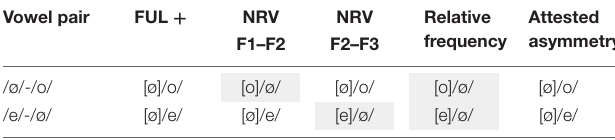
TABLE 3 | Overview of predictions for FUL, NRV and relative frequency.